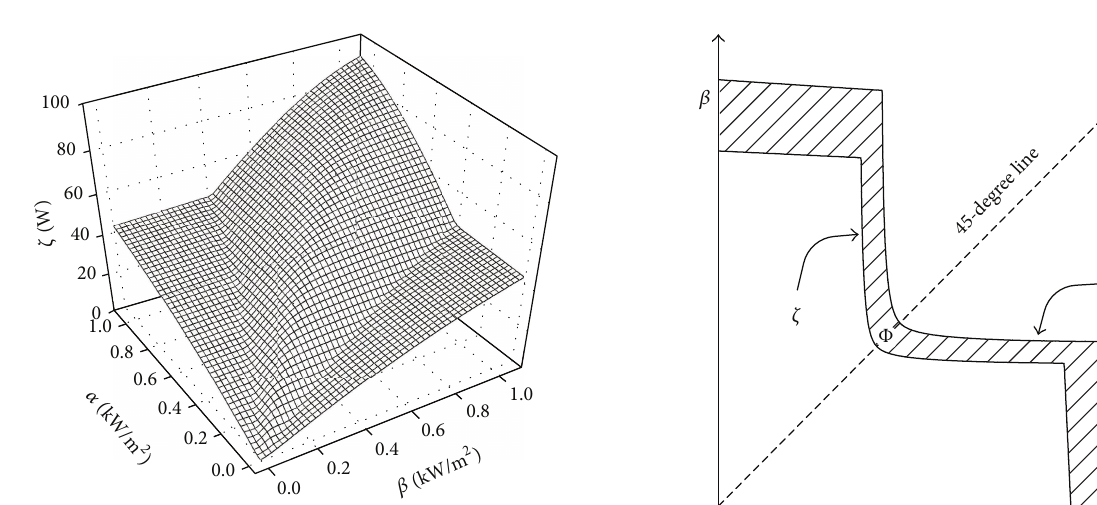
Figure 15: Three-dimensional view of the array maximum power 𝜁 as a function of 𝛼 and 𝛽 .